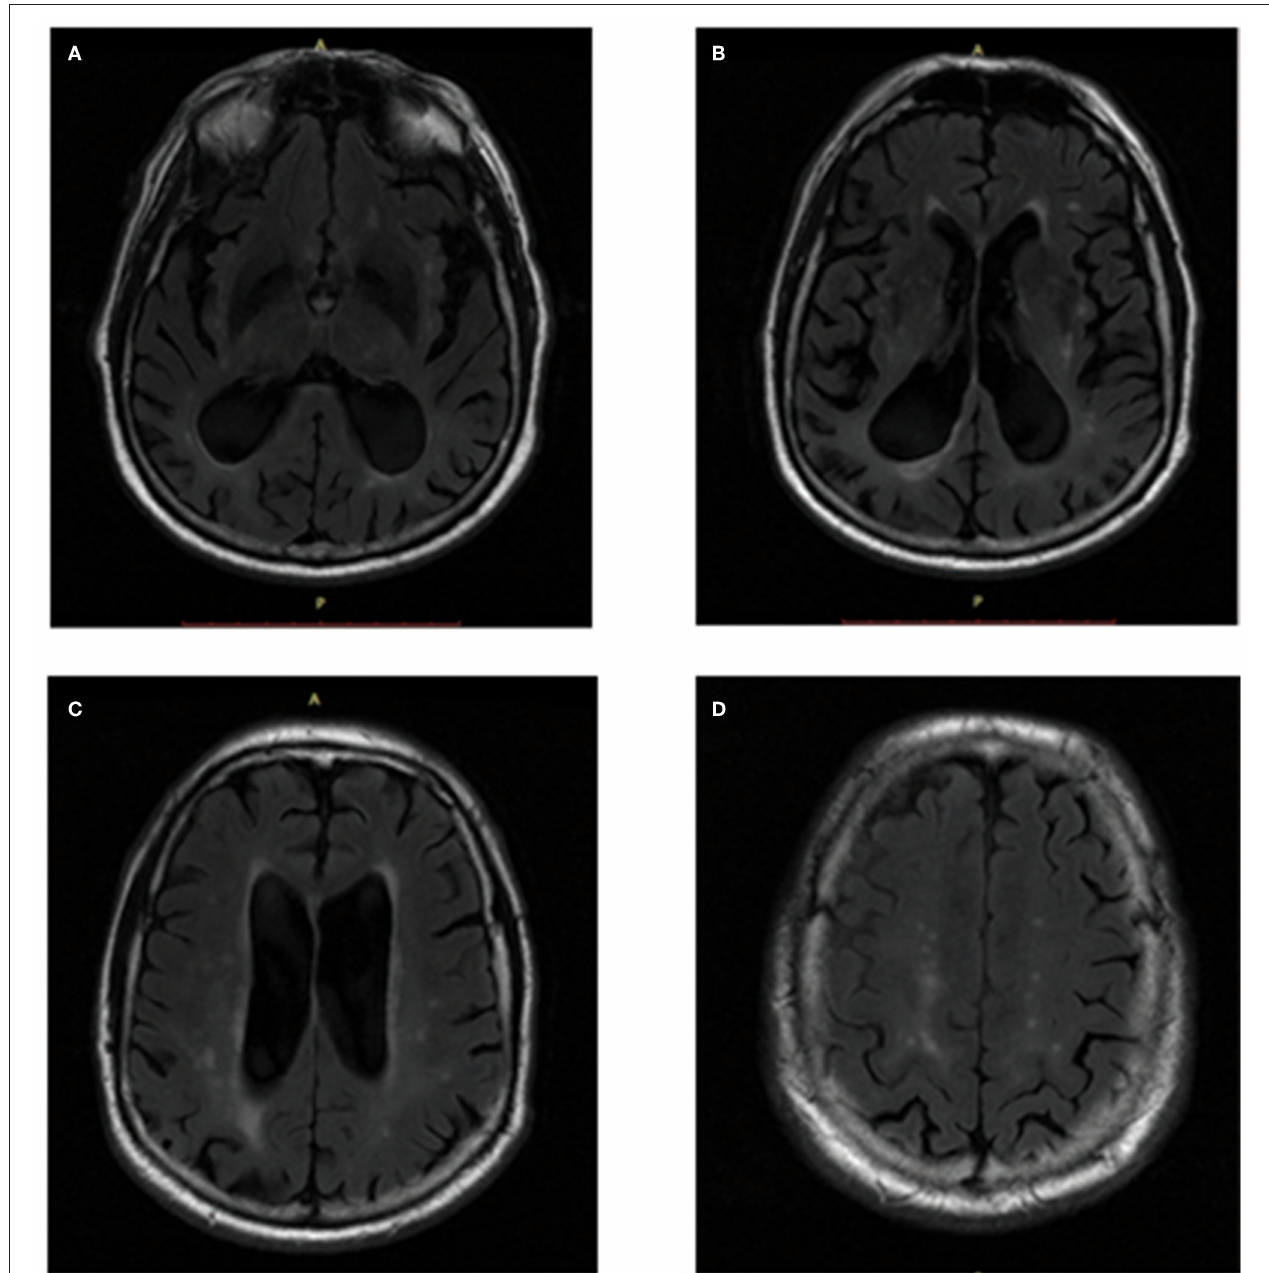
FIGURE 2 | CHIPS scores showed in T2-FLAIR images. (A) Low External Capsule: Anterior (Right = 0, Left = 1, Factor = 4, Total = 4); Posterior (Right = 1, Left = 1, Factor = 4, Total = 8). (B) High External Capsule: EC Anterior (Right = 1, Left = 1, Factor = 3, Total = 6); EC Posterior (Right = 1, Left = 1, Factor = 3, Total = 6); Cingulate (Right = 0, Left = 0, Factor = 4, Total = 0). (C) Corona Radiata: CR Anterior (Right = 1, Left = 1, Factor = 2, Total = 4); CR Posterior (Right = 1, Left = 1, Factor = 2, Total = 4); Cingulate (Right = 0, Left = 0, Factor = 1, Total = 0). (D) Centrum Semiovale: Anterior (Right = 0, Left = 1, Factor = 1, Total = 1); Posterior (Right = 1, Left = 1, Factor = 1, Total =